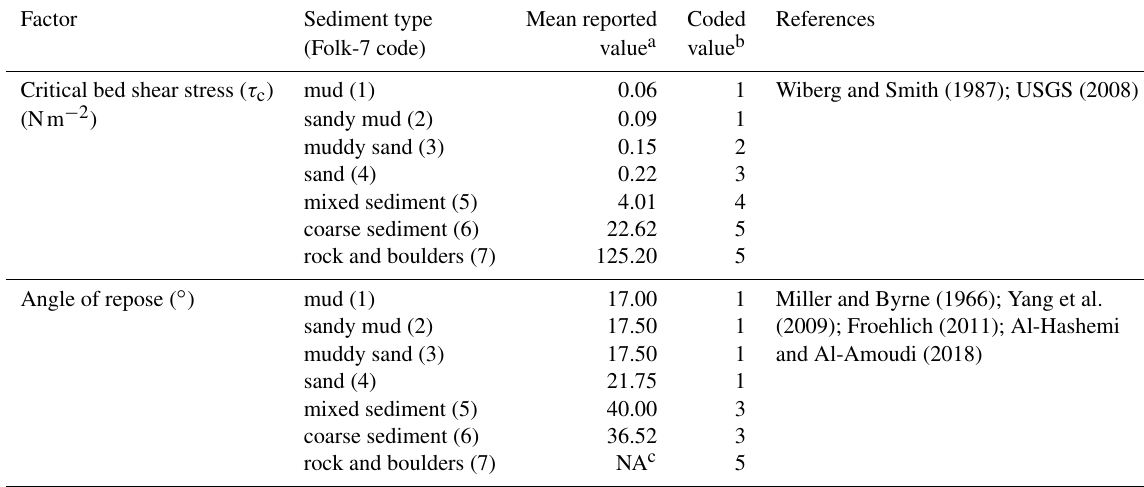
Table 1. Coded sediment properties.